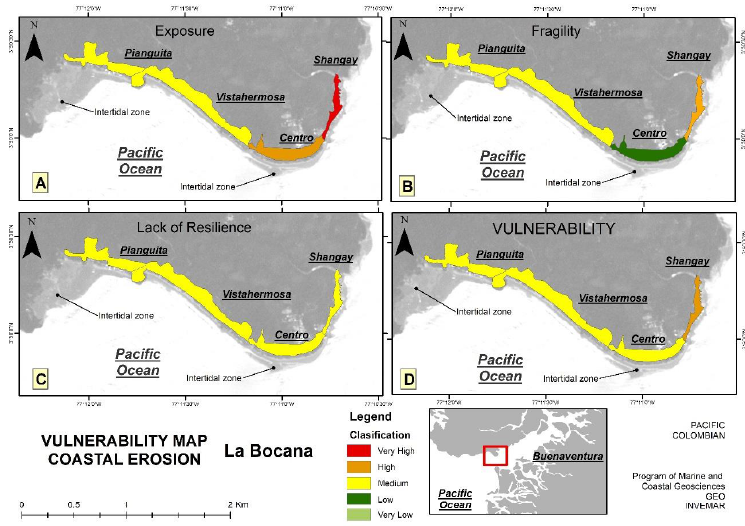
Figure 6. Vulnerability to coastal erosion in La Bocana settlement, Pacific Coast. ( A ) Exposure, ( B ) Fragility, ( C ) Lack of Resilience, and ( D ) Vulnerability.